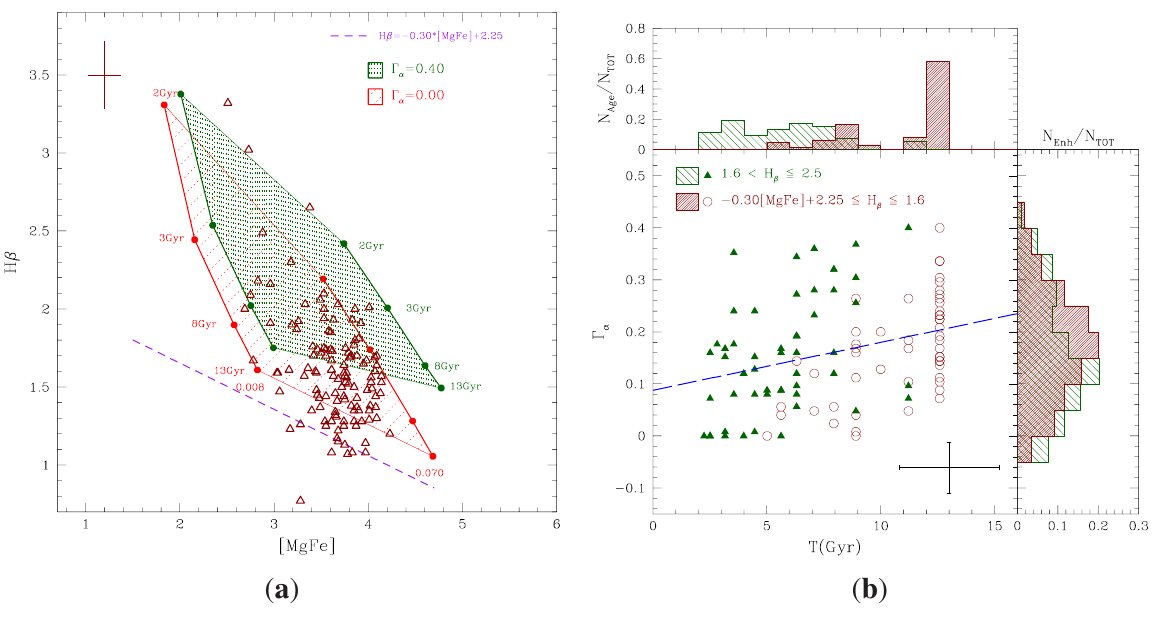
Figure 4. ( a ) H versus [MgFe] plane in presence of the enhancement in α -elements and β comparison between theory and observational data for galaxies in the local universe. Each hatched area is comprised between two SSPs of different metallicity ( Z = 0.008 left-side and Z = 0.070 right-side). Along each SSP the age increases from 2 (top) to 13 Gyr (bottom). Each area is for a different value of the total enhancement factor Γ (the definition α at varying metallicity is adopted). The data are the normal galaxies (open-triangles) of [60] corrected for emission (mean error bars are indicated). The dashed line is meant to provide a lower limit to H below which observational uncertainties may be so strong to render the β versus T (in comparison with theory meaningless (see the text for more details); ( b ) Γ α Gyr) plane. The data correspond to the sub-sample of the Trager catalogue selected to have 0 . 30[MgFe]+2 . 25 H 2 . 5 . Open circles are for 0 . 30[MgFe]+2 . 25 H 1 . 6 and β ≤ β ≤ − ≤ − ≤ filled triangles for 1 . 6 < H 2 . 5 . Long-dashed lines show the linear best fit for the whole β ≤ sample. Mean error in age and Γ is shown. The top panel gives the age distribution for both α sub-samples as indicated, whereas the right panel gives the Γ distribution. Reproduced with α permission from [68]. Copyright 2007 International Astronomical